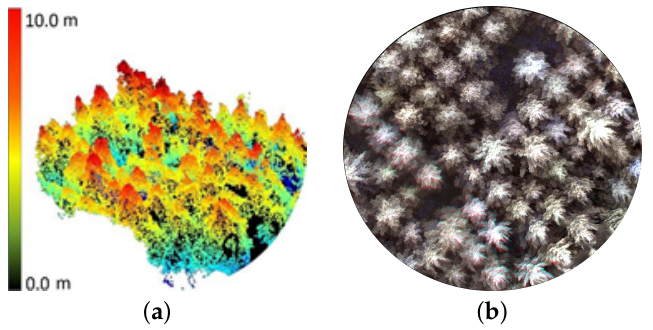
Figure 3. The 3D point cloud ( a ) and orthomosaic ( b ) corresponding to a plot are used as the source of structural and spectral information, respectively, by the S3-ITD method.